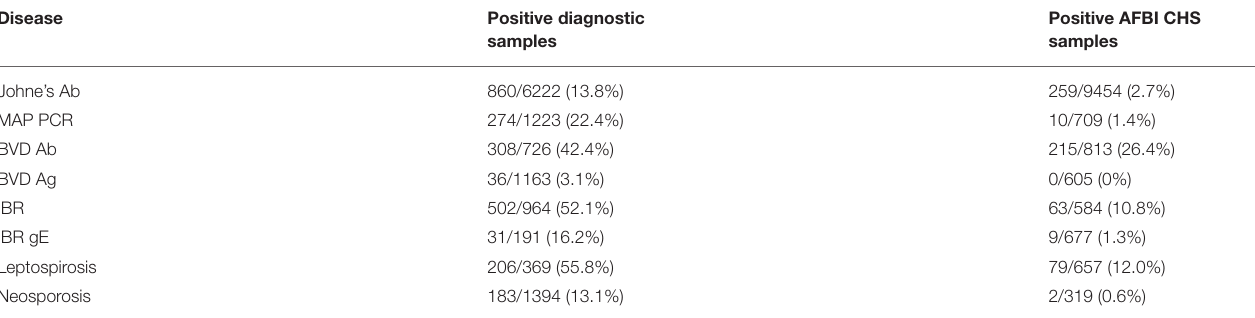
TABLE 5 | A summary of AFBI diagnostic and CHS results.